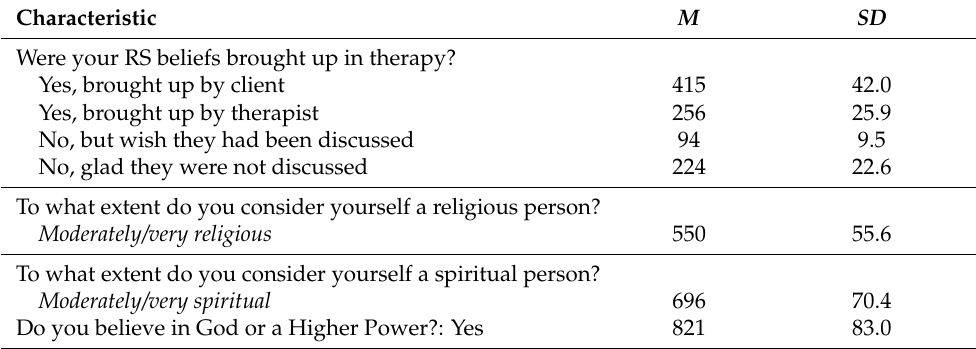
Figure 2. Final Model with Standardized Loadings and Correlated Error Terms. RSIPAS-CAv2 = Religious/Spiritually Integrated Practice Assessment Scale-Client Attitudes, version 2. As com- pared to the first study (Oxhandler et al. 2018b), seven of the current study’s item loadings in- creased between 0.03 and 0.11, items 3 and 5 both dropped by 0.03, and item 7 remained at 0.70. This suggests our sample had a better fit for the revised items, which makes sense given our focus on current clients rather than a sample that mostly last saw a therapist years ago. Item 6’s loading increased from 0.17 in the original study to 0.44 in the current study but did not meet the 0.45 threshold we had set for item retention (Comrey and Lee 1992) and was removed. 3.2. Client Attitudes Toward RS Integration We also explored the descriptive responses to the original 10 items that were in- cluded within the survey (Table 3). Most clients agreed with the following: “A good ther- apist is sensitive to clients’ religious/spiritual beliefs” (75.6%, with 7.3% disagreeing), and “I would be open to discussing my religious/spiritual beliefs in therapy” (71.0%, with 12.0% disagreeing). Clients also largely agreed with “My religious/spiritual beliefs are im- portant to me during difficult times” (65.9%) and “It is important for my therapist to know how to discuss my religion/spirituality in mental health therapy” (58.9%). Most clients (51.2%) reportedly agree that discussing their RS beliefs in treatment improves their men- tal health outcomes. Finally, over half of clients agreed with 9 out of the 10 reported items, with the exception of whether the therapist should first ask about the client’s RS (43.5%), which still had the highest proportion of positive responses compared with neutral and disagree. In fact, clients were fairly mixed on who should initiate the discussion of RS in therapy, with 43.5% preferring for the therapist to bring it up and 50.8% preferring to bring it up themselves. These two items also had a fairly high proportion of neutral re- spondents (24.5% and 28.5%, respectively) compared with the other eight items included within the survey.